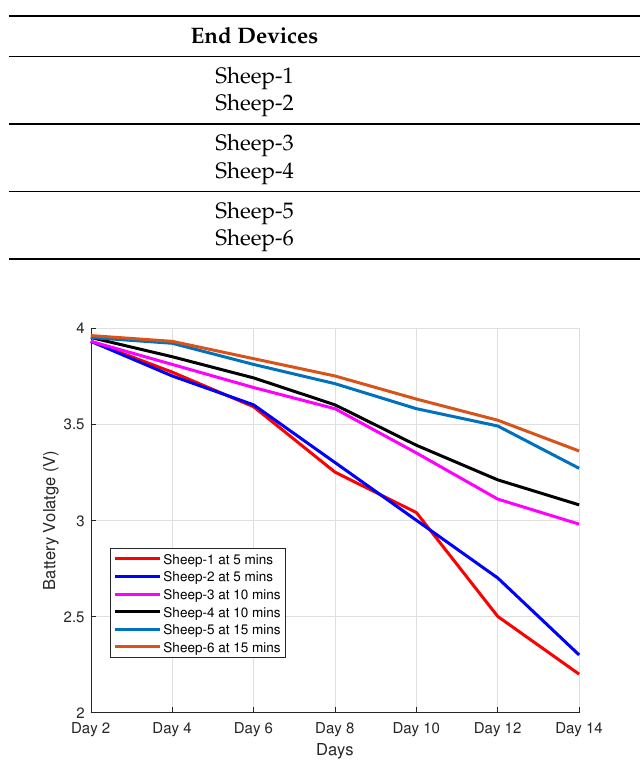
Table 3. Sampling intervals.